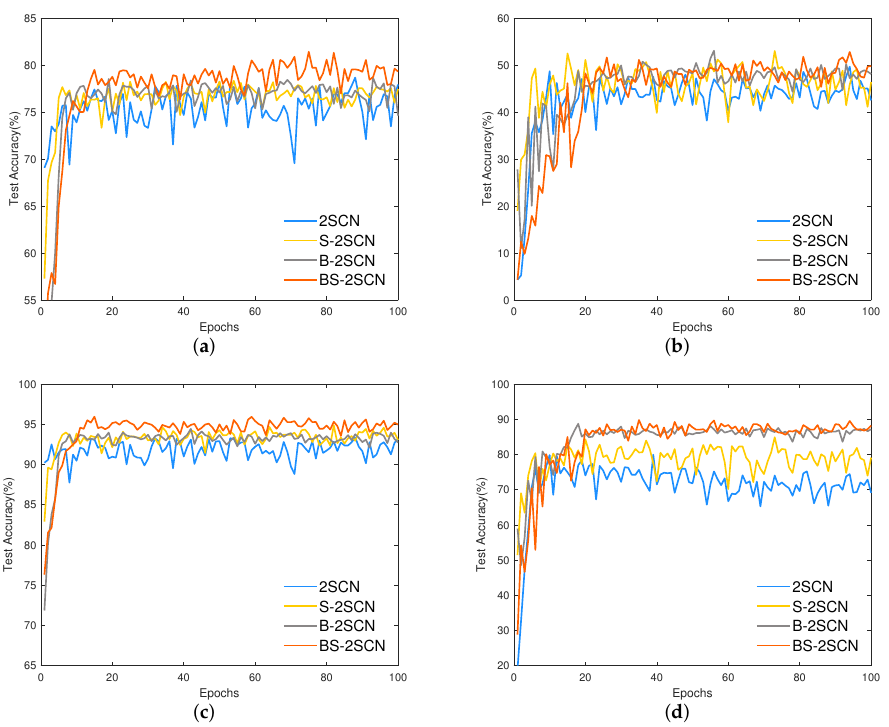
Figure 8. Accuracy of spatial stream network on two data sets. ( a ) UCF101 (top1). ( b ) HMDB51 (top1). ( c ) UCF101 (top5). ( d ) HMDB51 (top5).